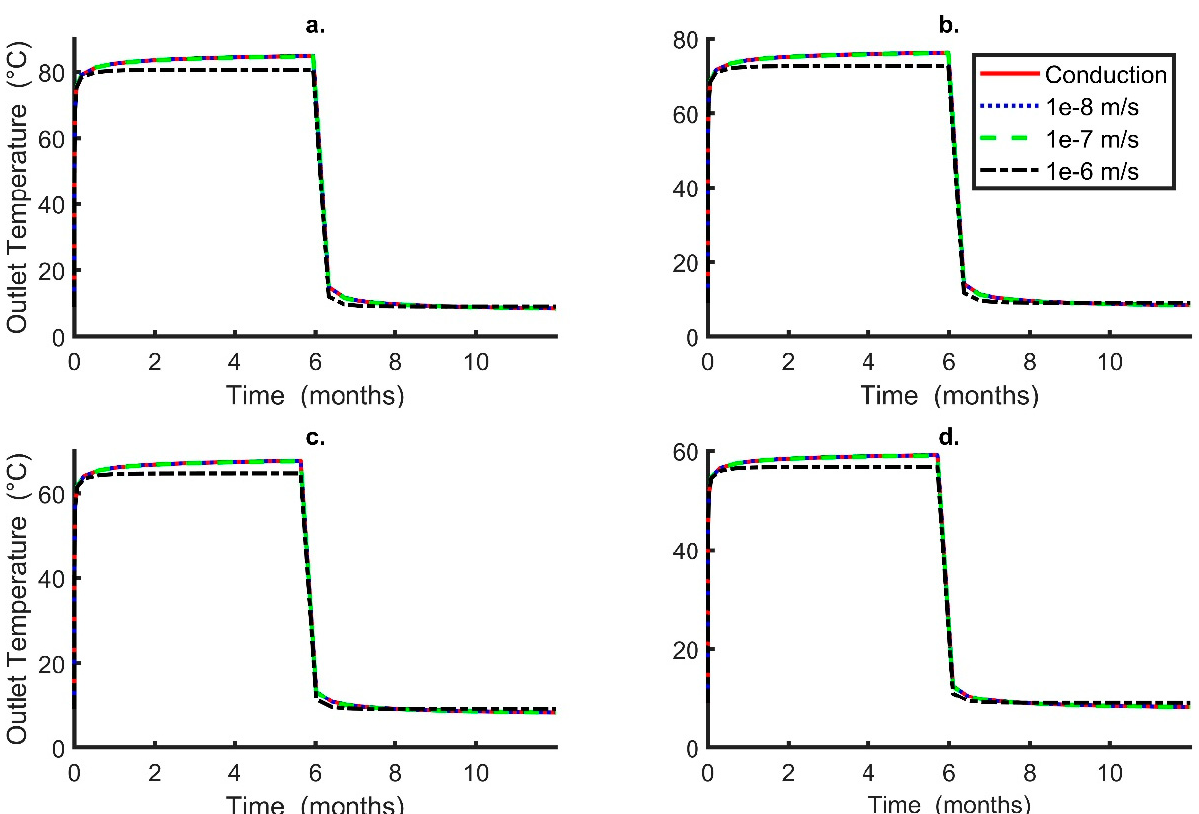
Figure 9. Impact of groundwater Darcy velocity on DBHE outlet temperature for a 6 month charge followed by 6 month discharge period. DBHE internal flow rate = 5 L/s and constant inlet temperature during discharge is 5 ◦ C. ( a ) is for constant 95 ◦ C inlet temperature, ( b ) is for 85 ◦ C inlet temperature, ( c ) is for 75 ◦ C inlet temperature and ( d ) is for 65 ◦ C inlet temperature.